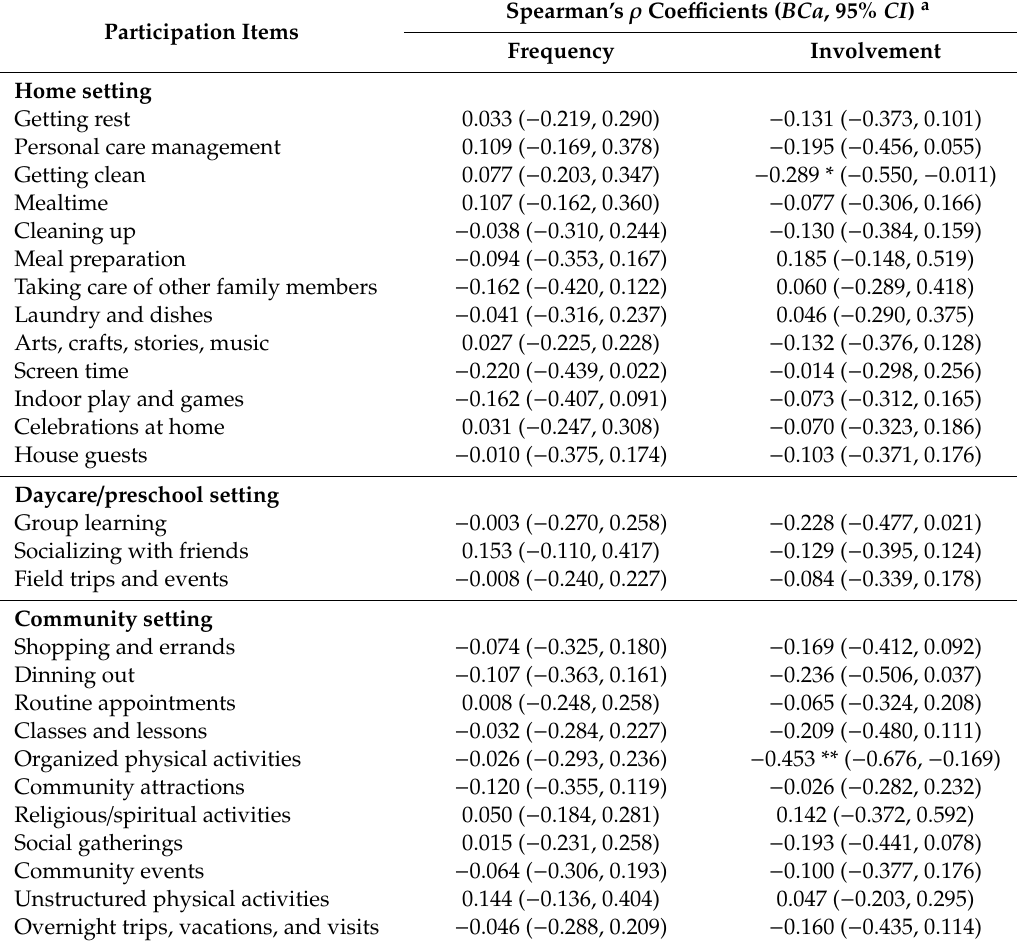
Table 5. Correlations between the scores of the parents’ a ffi liate stigma and children’s participation in each activity across three